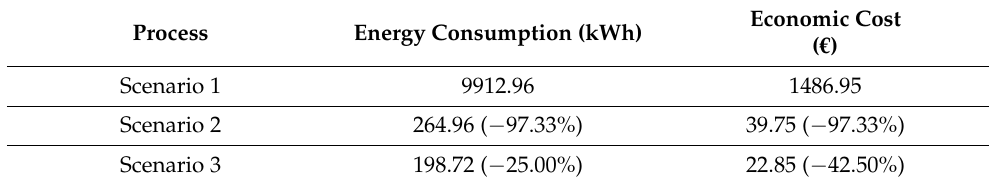
Table 7. Comparison of energy consumption and economic cost of the different